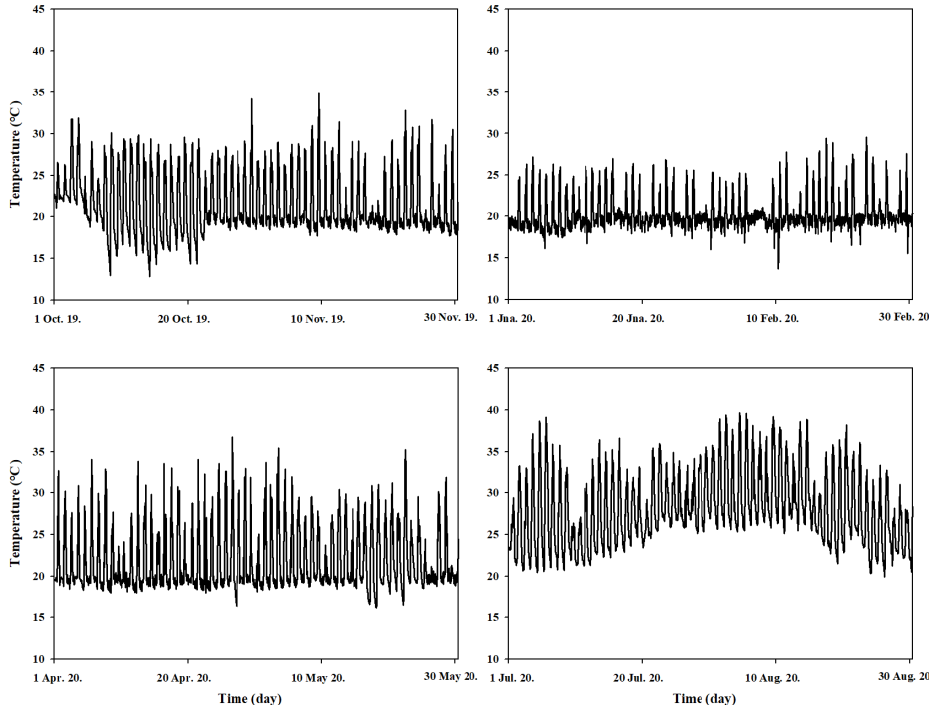
Figure 1. Air temperature in the greenhouse during the cultivation periods of cuttings, rootstocks and grafts from October 2019 to August 2020.